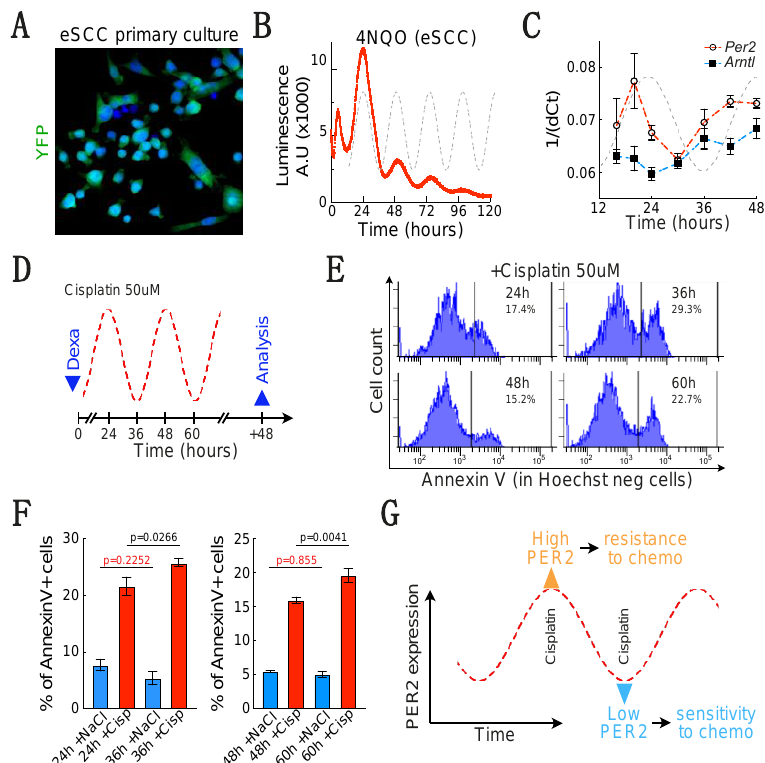
Figure 6. A low PER2 expression is associated to a higher sensitivity to cisplatin in mouse eSCC epithelial cells. ( A ) Endogenous YFP fluorescence in primary culture of 4-NQO-induced eSCC epithelial cells. ( B ) Real time monitoring of luciferase activity in primary culture of 4-NQO-induced eSCC epithelial cells. ( C ) PER2 and Arntl expression on the 4-NQO induced eSCC epithelial cells measured by qPCR for 48 h after dexamethasone-induced synchronization. ( D ) Experimental design to treat 4-NQO-induced eSCC epithelial cells when Per2 expression is high or low (24 or 36 h after dexamethasone-induced synchronization). ( E ) Representative histogram showing the proportion of Hoechst-/Annexin V 4-NQO-induced eSCC epithelial cells measured by flow cytometry 48 h after the end of the cisplatin treatment. Cells were either not treated (NaCl = vehicle) or treated for 4 h with 50 μM cisplatin 24, 36, 48 or 60 h after synchronization. ( F ) Histogram summarizing the proportion of Hoechst-/Annexin V+ 4-NQO-induced eSCC epithelial cells measured 48 h after the end of the cisplatin treatment. Data are represented as mean +/− SEM. p -values were calculated using a two-way ANOVA followed by Sidak’s post hoc test. First cycle ( n = 8). Fixed effect: Time/ p = 0.3788; Cisplatin/ p < 0.0001; Time x Cisplatin/ p = 0.0067. Second cycle ( n = 5). Fixed effect: Time/p = 0.0231; Cisplatin/p < 0.0001; Time x Cisplatin/ p = 0.0231. ( G ) Scheme depicting our main observations in esophageal cancer cells.